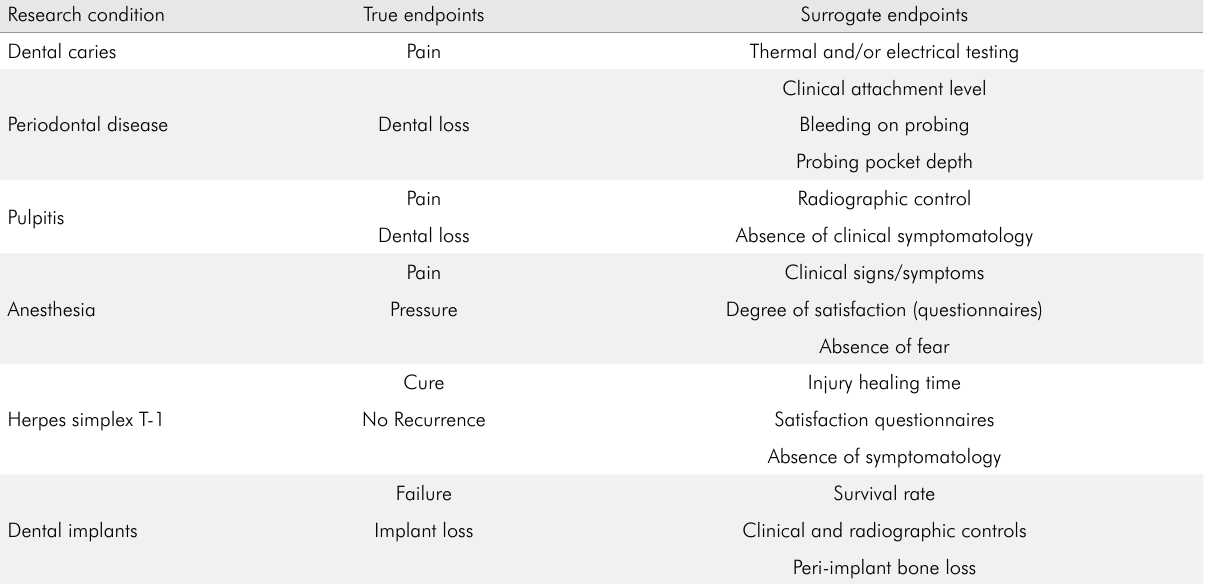
Table 2. Some samples of True Endpoints and Surrogate Endpoints in Clinical Dentistry. Research